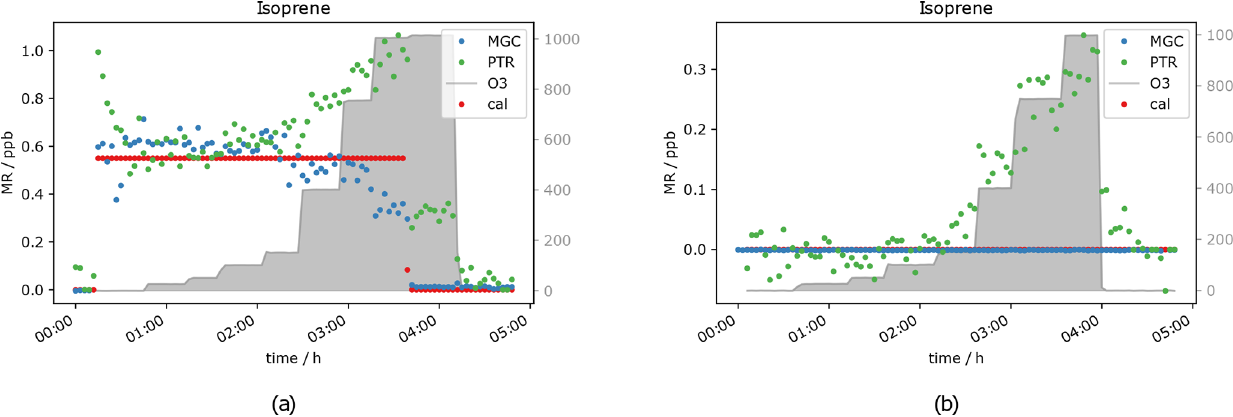
Figure 9. Isoprene mixing ratio at different ozone levels.